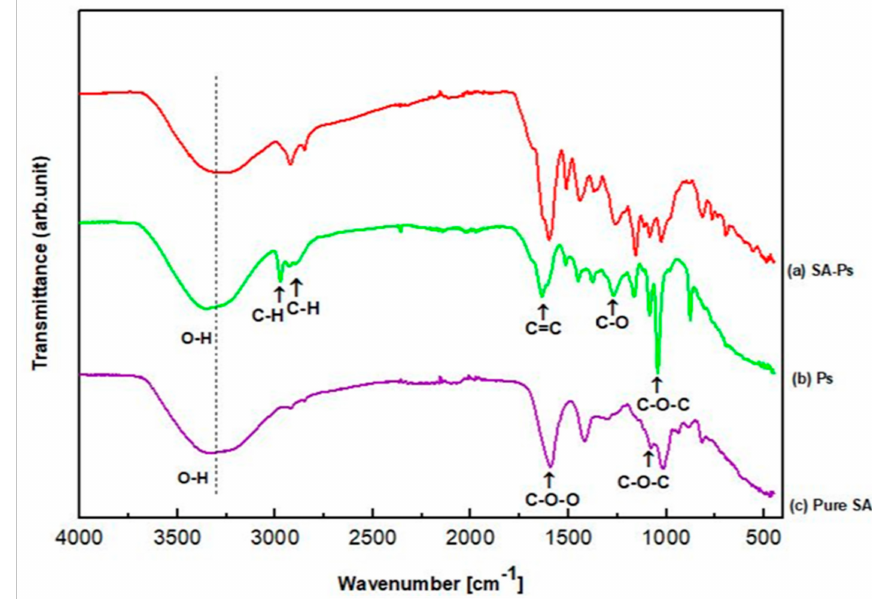
Figure 3. FT-IR spectrums of ( a ) SA with Ps tissue sca ff olds, ( b ) only Ps solution and ( c ) pure SA